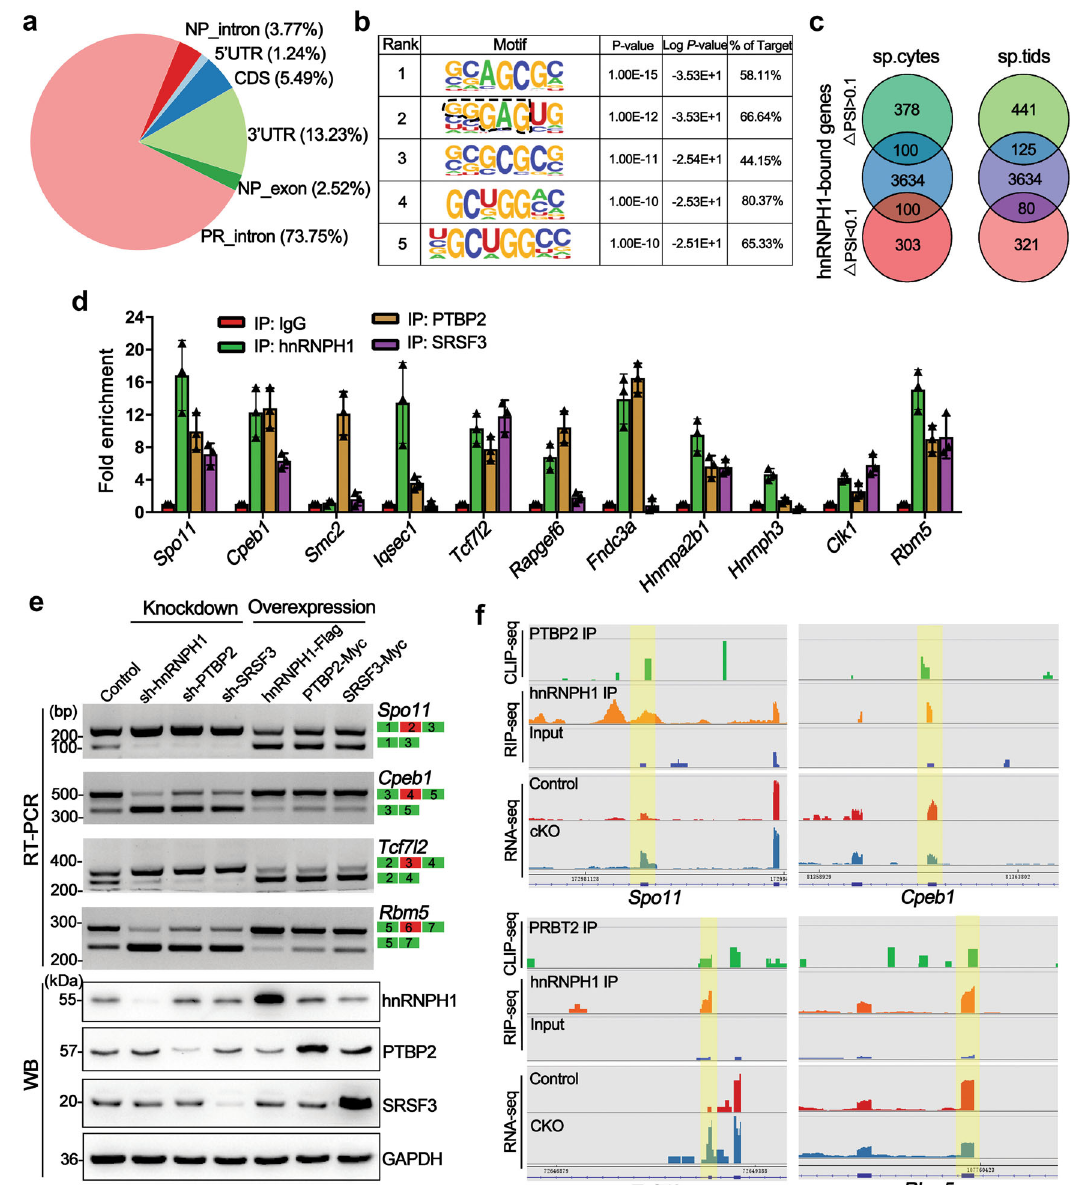
Fig. 8 hnRNPH1 cooperates with PTBP2 and SRSF3 to regulate mRNA splicing. a Pie-chat shows the summary of binding locations for hnRNPH1 RIP- sequencing (RIP-seq) in spermatogenic cells isolated from P28 WT testes. b Top fi ve sequence motifs identi fi ed from RIP-seq peaks in spermatogenic cells are shown. c Venn diagrams showing overlap of hnRNPH1 bound genes and abnormal AS genes (with Δ PSI >0.1 and Δ PSI <0.1, respectively) in hnRNPH1 cKO spermatocytes (left) and spermatids (right). d Histograms show RIP-qPCR analyses of selected mRNA of 11 genes co-precipitated by anti-hnRNPH1, anti-PTBP2, anti-SRSF3 antibodies, and control IgG in RIP experiments performed from puri fi ed germ cells. Data were presented as mean ± SD, n = 3 (three biological replicates). e RT-PCR and WB analyses of splicing assays were performed in HEK293T cells transfected with the indicated minigenes and knockdown/overexpression-related vectors for hnRNPH1, PTBP2, and SRSF3. Biologically independent experiments ( n = 3) were examined. f Alternative sites in four representative genes bound directly by hnRNPH1, SRSF3, and PTBP2 from RNA-, RIP-, and CLIP-seq using IGV software. Splicing sites are indicated by the yellow